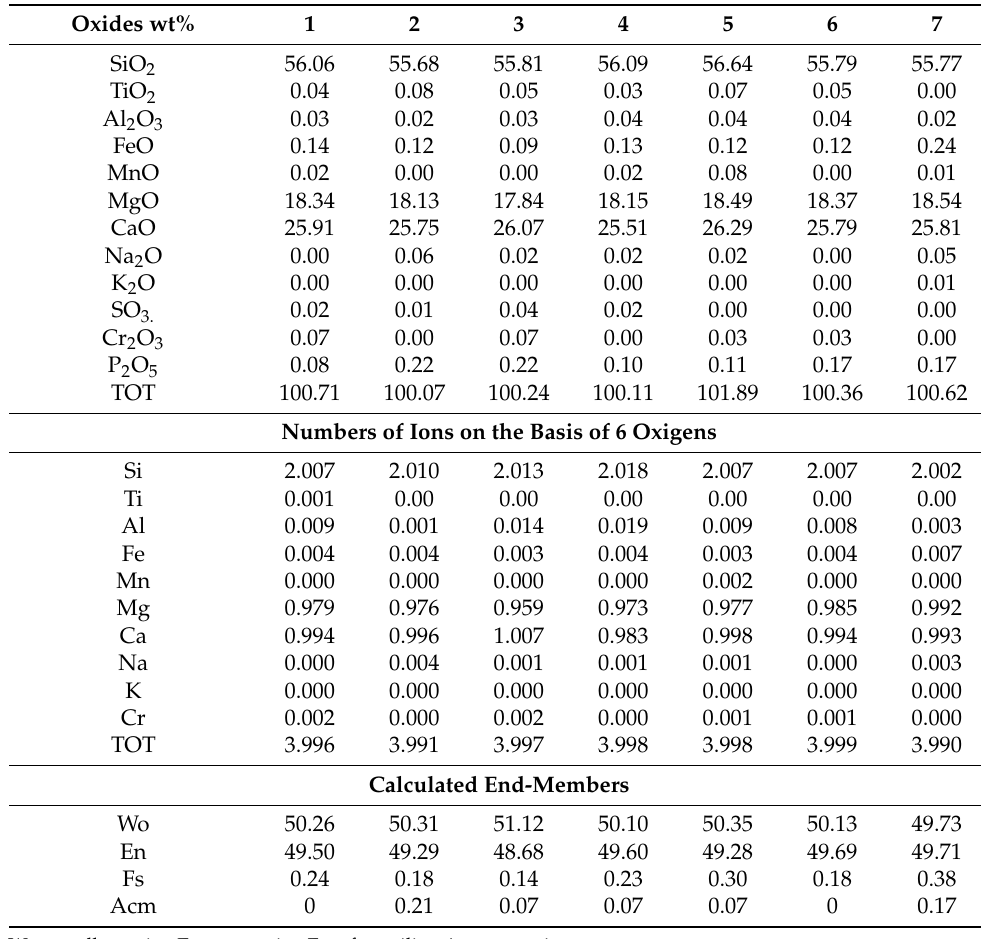
Table 4. Mineral chemistry obtained through EMPA of the investigated diopsides of the lens of Figure